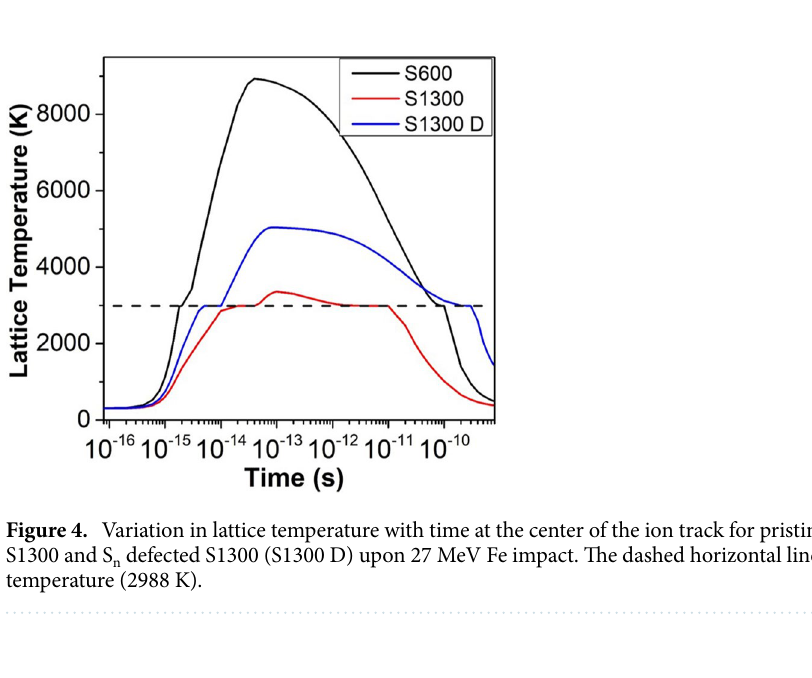
Maximum temperature Duration of thermal spike S600 ~ 8900 K ~ 100